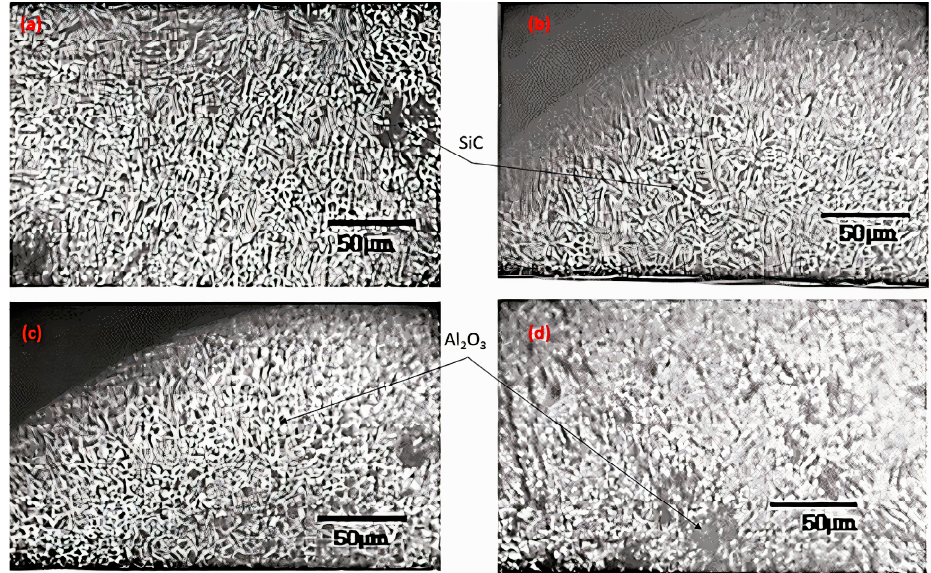
Figure 8. Optical microscopy images: ( a ) steel mold, ( b ) graphite mold for 1 wt.% SiC particles, and ( c ) steel, ( d ) graphite mold for 8 wt.% Al 2 O 3 particles.